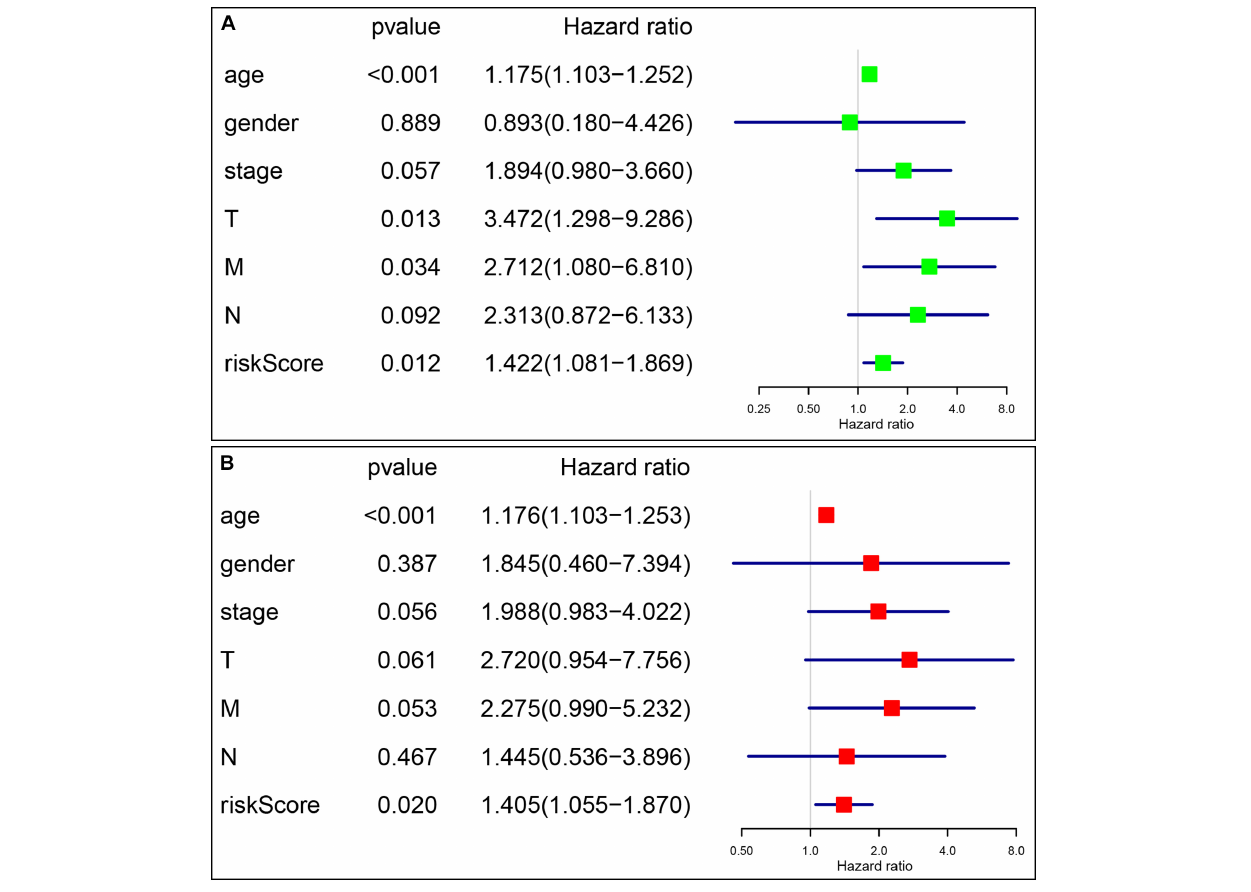
FIGURE 9 | Identification of the independent prognostic factors in the validation group. (A) Univariate Cox analyses of the signature based risk score and clinicopathological parameters in validation cohort; (B) Multivariate Cox analyses of the signature based risk score and clinicopathological parameters in validation